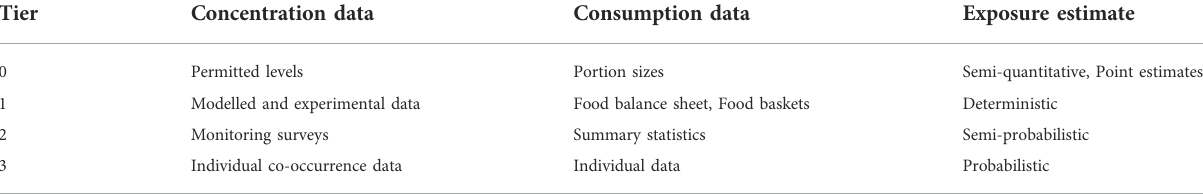
TABLE 1 Example of tiering in exposure assessment a